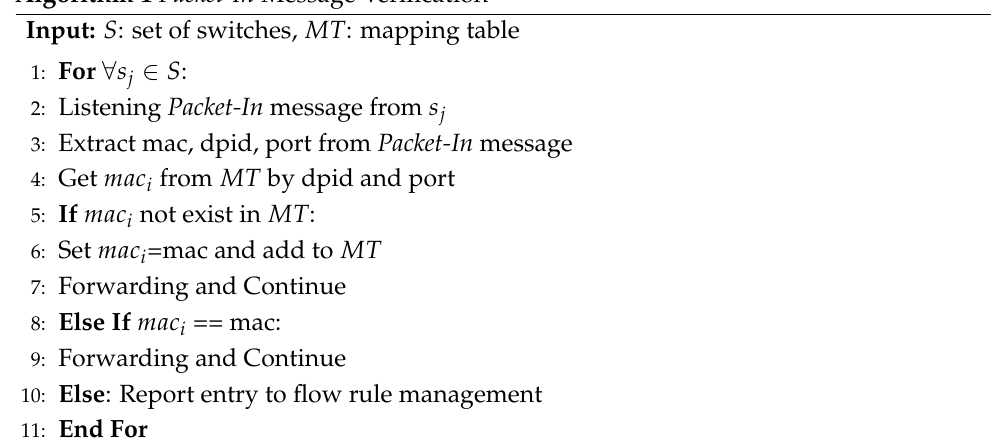
Algorithm 1 Packet-In Message